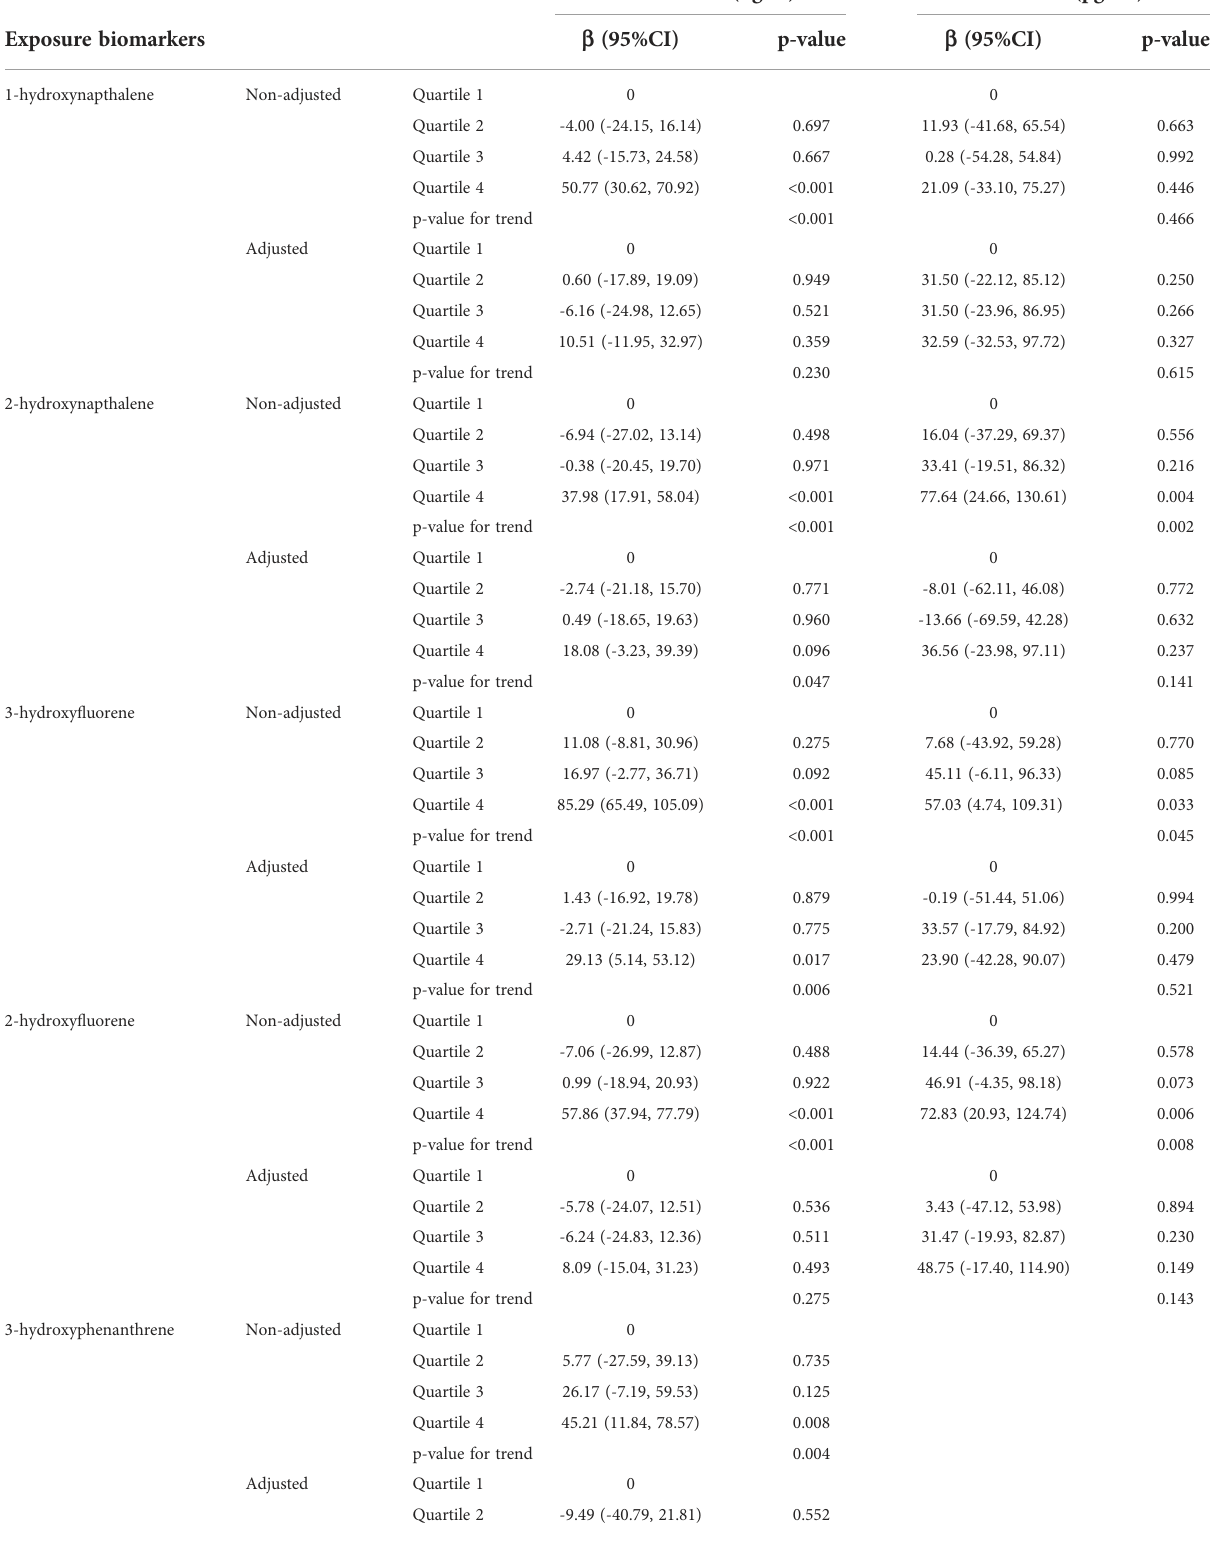
Testosterone (ng/dl) Estradiol (pg/ml)